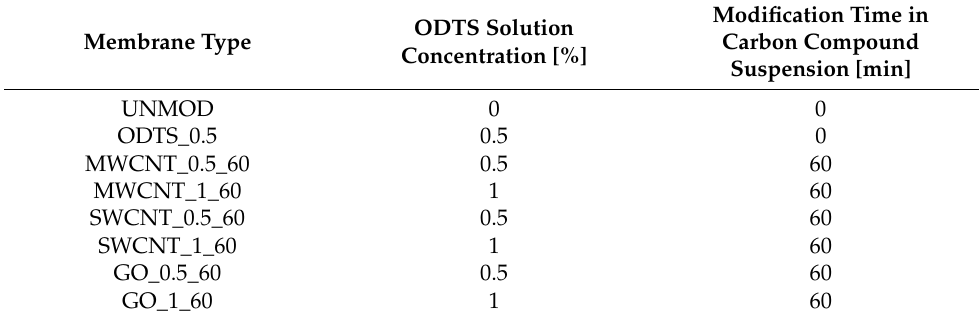
Table 2. Modification process parameters of the test membranes in the flow-through system.